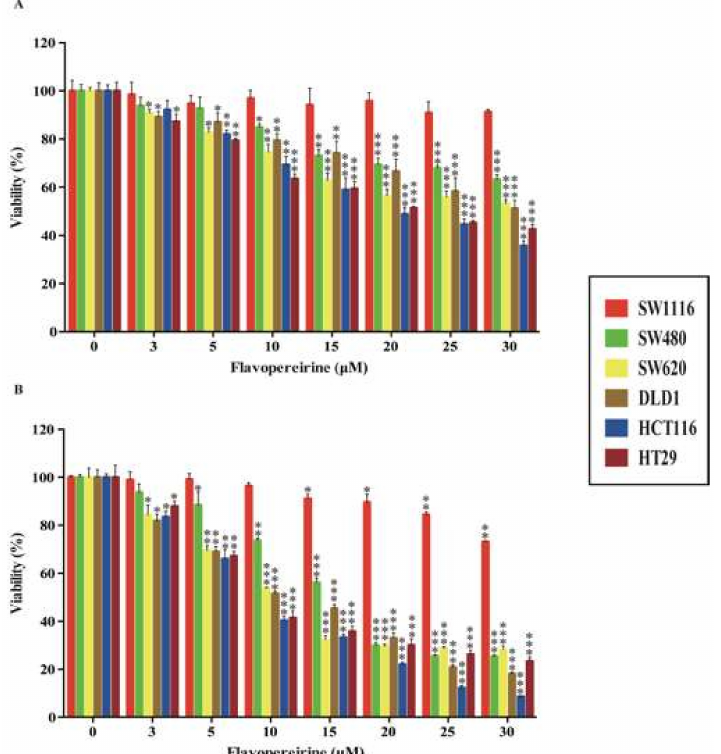
Figure 1. Flavopereirine lowered the viability of various CRC cell lines. CRC cells were treated with various concentrations of flavopereirine for 24 h and 48 h and their viability was assayed by CCK8. Values were expressed as cell viability [%]. Each value represented the mean ± SD of quadruplicate assays. * p < 0.05; ** p < 0.01, *** p < 0.001 compared with the control. Similar results were obtained for at least three independent